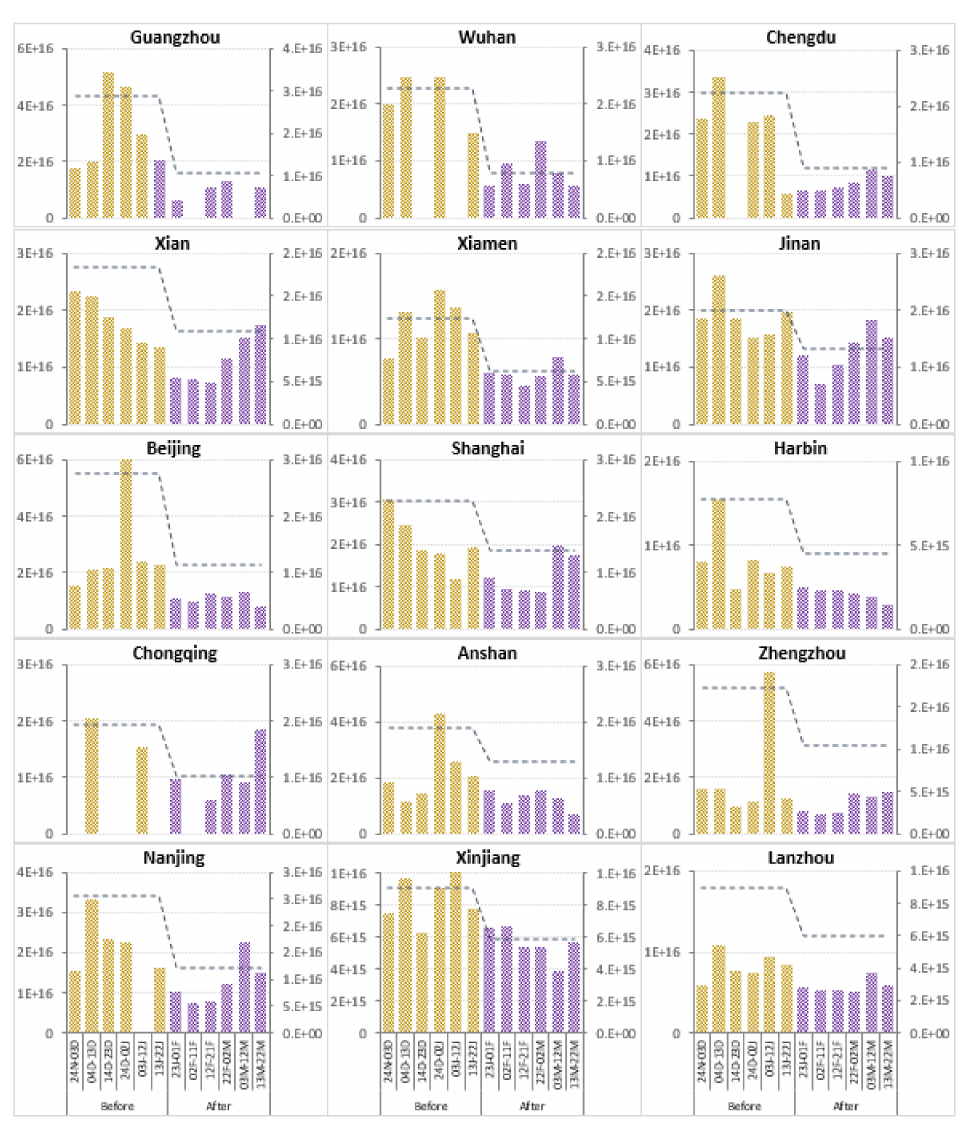
Figure 7. Absolute trend line indicates 60-day average of NO 2 tropospheric column (molecules/cm 2 ), whereas the bar graph represents 10-day average concentration (X-axis) of NO 2 in 15 major cities of China before (yellow) and after (purple) the COVID-19 lockdown period. Source: OMI, Global Modeling and Assimilation Office, NASA,